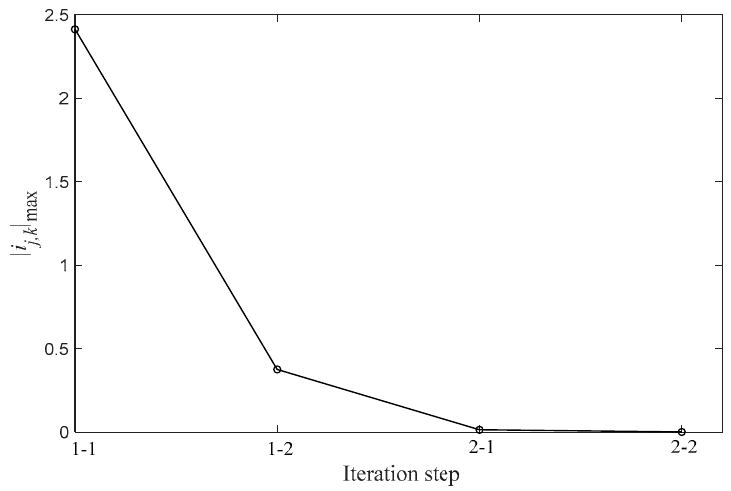
Figure 9. Additional radial hydraulic gradient in the iteration step.